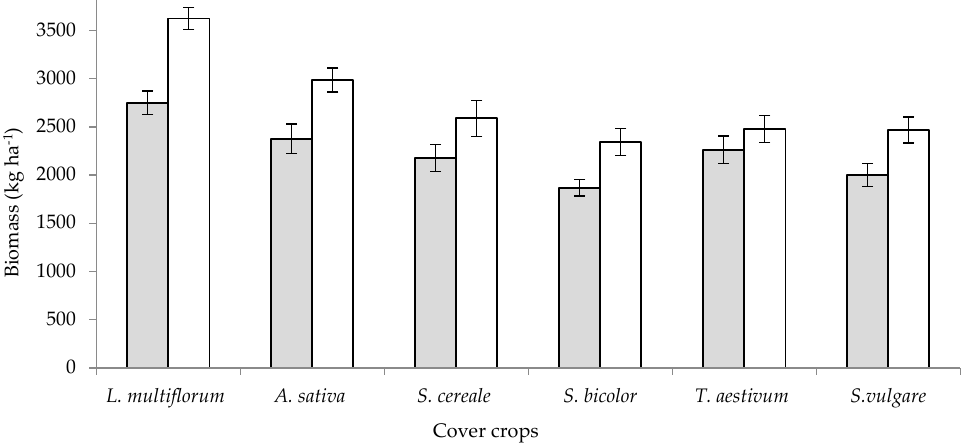
Figure 1. Biomass production (kg ha − 1 ) of cereal cover crops in different vegetable production systems prior to termination in 2005 (gray bars) and 2006 (white bars). Vertical lines represent standard errors of the means ( p < 0.05) [49,50].